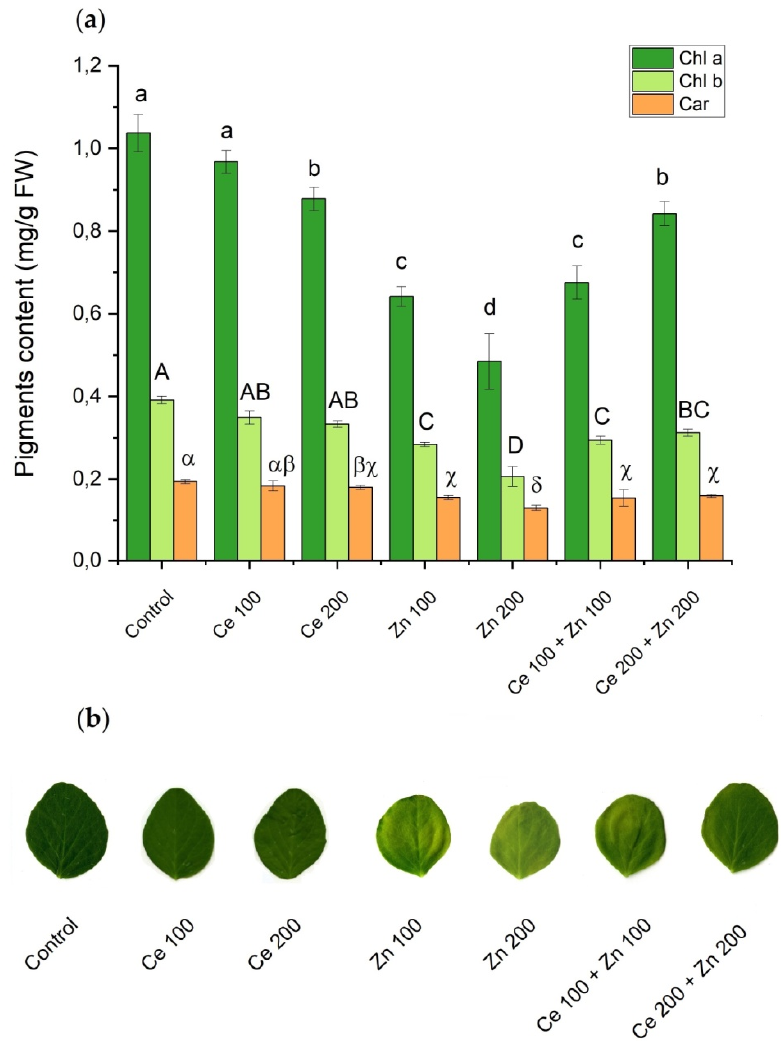
Figure 2. The influence of nanoparticulate CeO 2 and ZnO on: ( a ) photosynthetic pigments: chloro- phyll a (Chl a), chlorophyll b (Chl b), and carotenoids (Car) in Pisum sativum L. The pigments were extracted from mature leaves after 12 days of contact with a particular nano-oxide. Vertical bars represent standard deviations ( n = 6). Treatments with the same letter are not significantly different according to Tukey’s post hoc test ( p = 0.95) ( b ) appearance of pea leaves from each treatment.